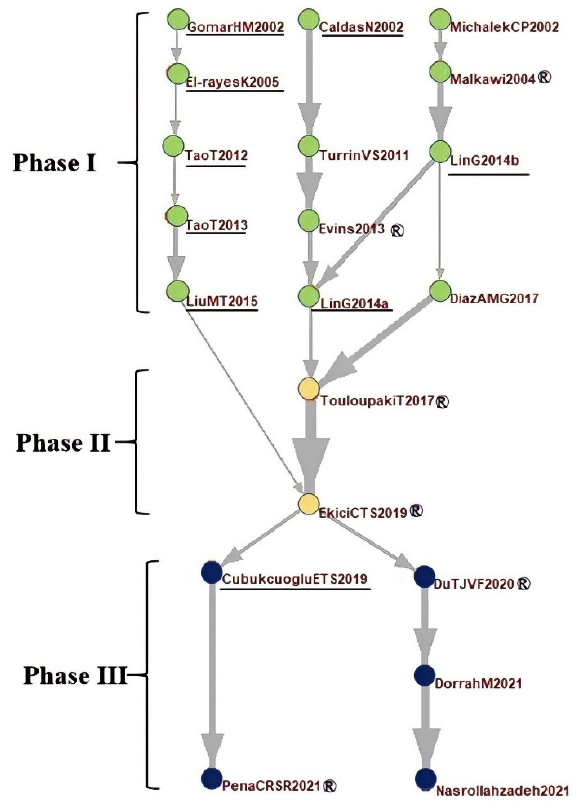
Figure 5. Main Paths A. Table 1. Articles in Main Paths